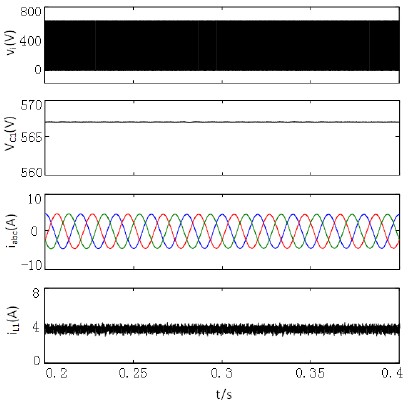
Figure 10. Simulation waveforms of the grid-side in half quasi-Z-source wind power generation system (WPGS).